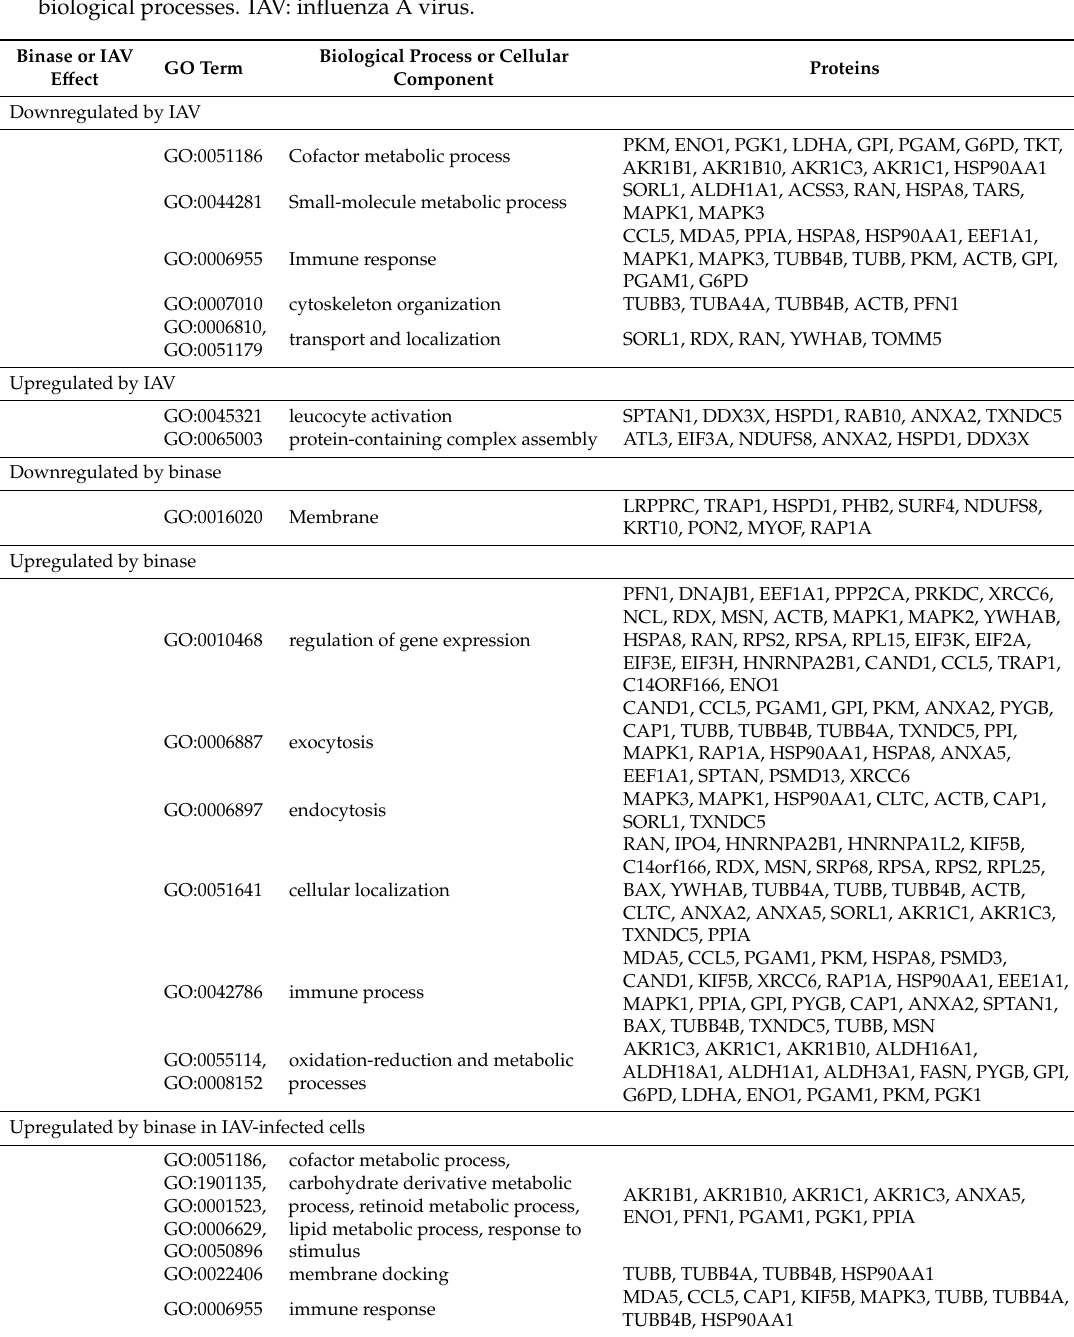
Table 1. Enrichment of A549 cell proteins a ff ected by the virus and / or binase in the gene ontology (GO) biological processes. IAV: influenza A